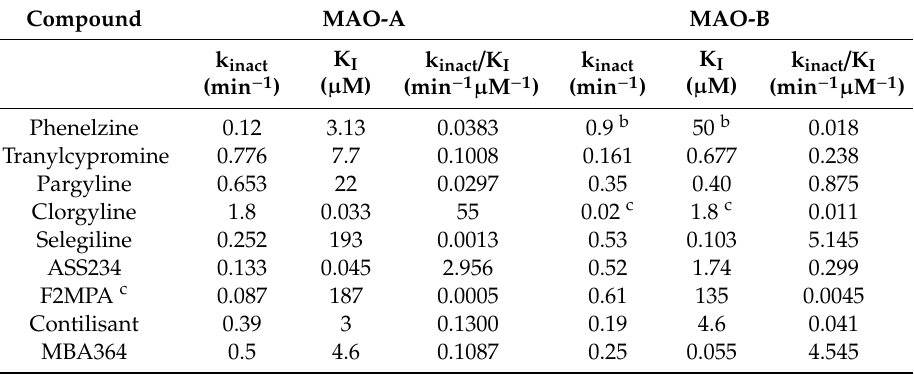
Table 3. Parameters for inactivation of MAO-A and MAO-B a . Compound